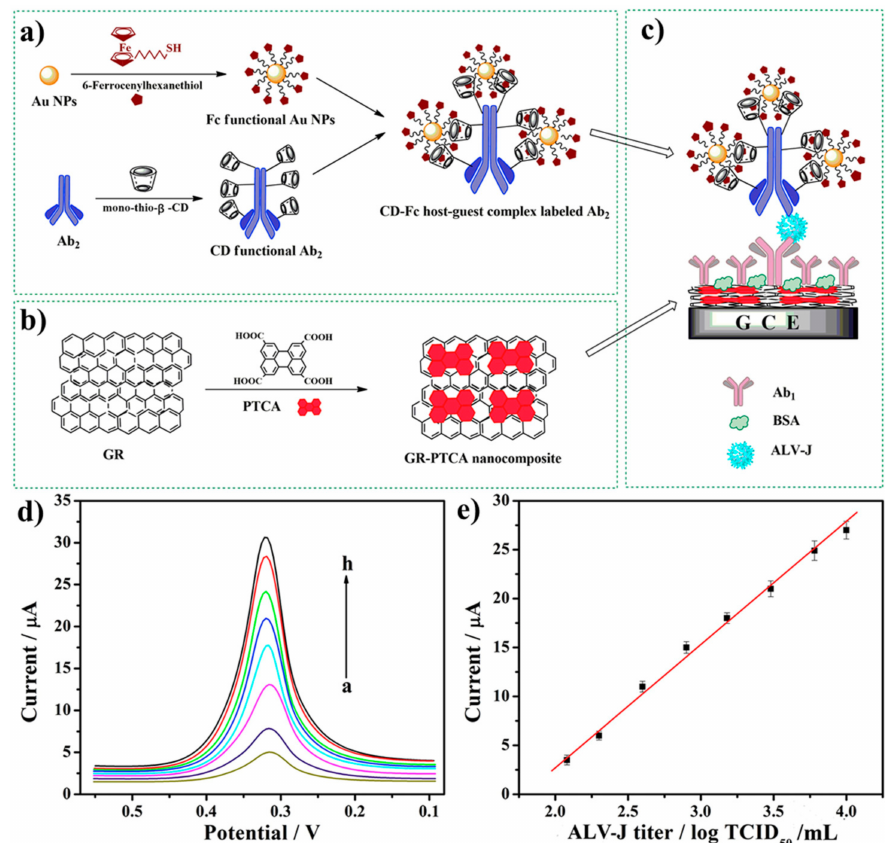
Figure 10. ( a ) Schematics of the fabrication of Ferrocene–AuNP– β –cyclodextrin–Ab 2 , ( b ) GR–PTCA, and ( c ) the electrochemical immunosensor. ( d ) The DPV responses of the immunosensor in the presence of varying concentrations of avian leukosis virus (10 2.0– 10 4.0 TCID 50 /mL). ( e ) The linear calibration plot for the determination of avian leukosis virus. Reproduced with permission from reference [50]. Copyright © 2020 Elsevier